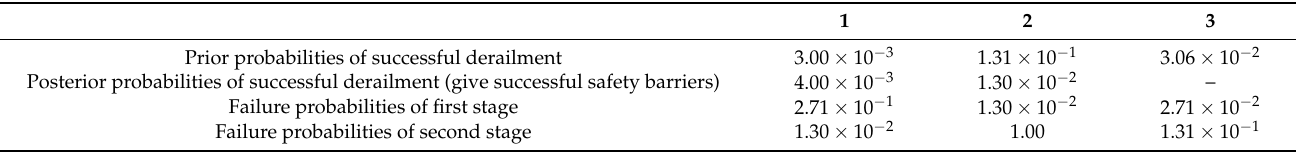
Table 5. The probabilities of actual accidents and safety layer